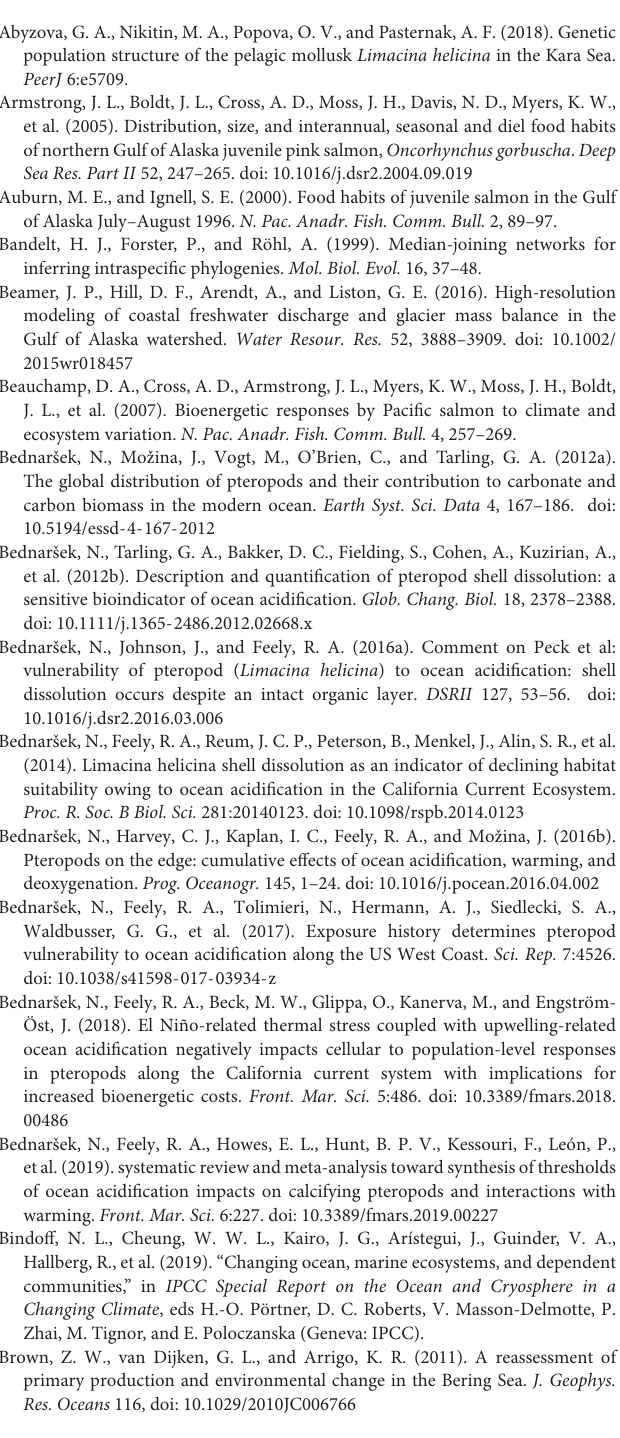
sequence pairs between groups below the diagonal, standard error estimate(s) derived from 500 bootstrap replicates are above the diagonal. The samples originate from the North Pacific (abbr. ENPac), Greenland (abbr. Grnld), Kara Sea (abbr. Kara), Hudson Bay (abbr. NCanada), Western North Pacific (abbr. WNPac), Svalbard (abbr. Svbd) and White